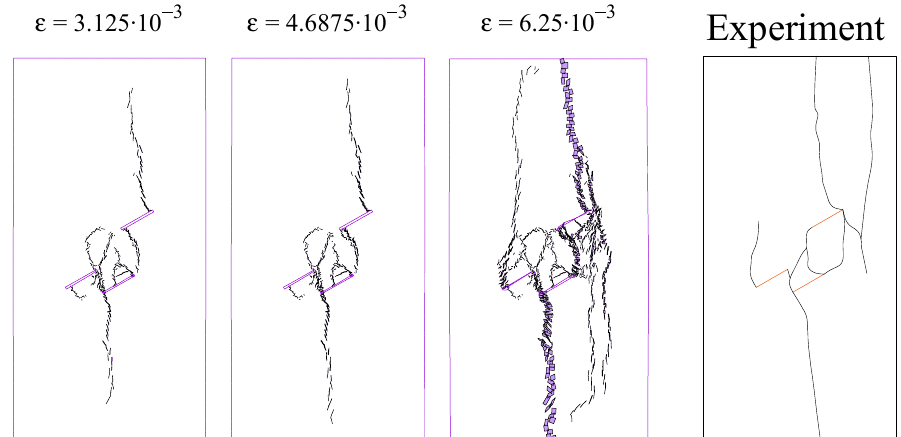
Figure 9. Sandstone containing three pre-existing fissures (Case 3): the crack opening plots (deformation scale 1:1) compared to the experimental results provided in [82].